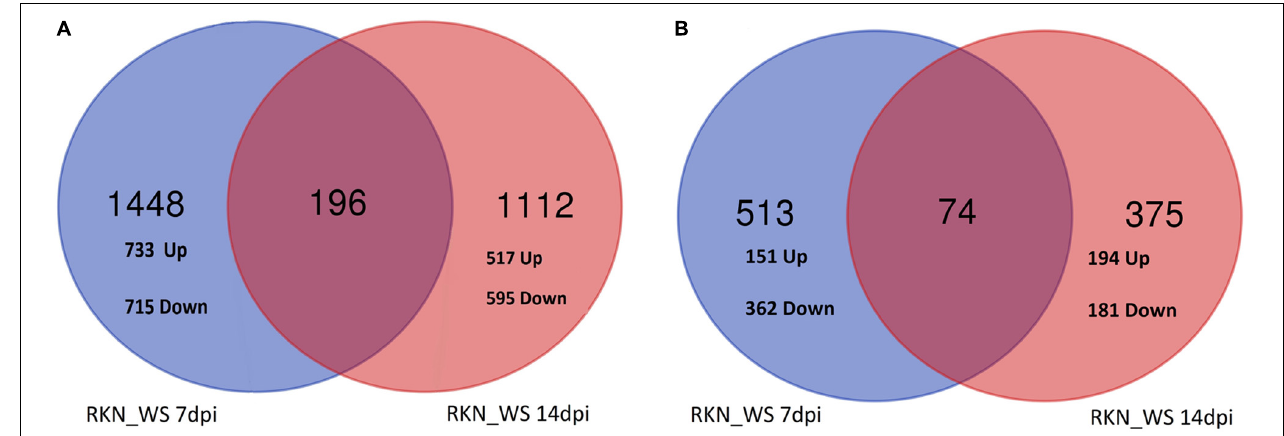
FIGURE 5 | Venn analysis of RKN_WS DEGs exclusive (A) and in common with RKN (B) , along the two sampling